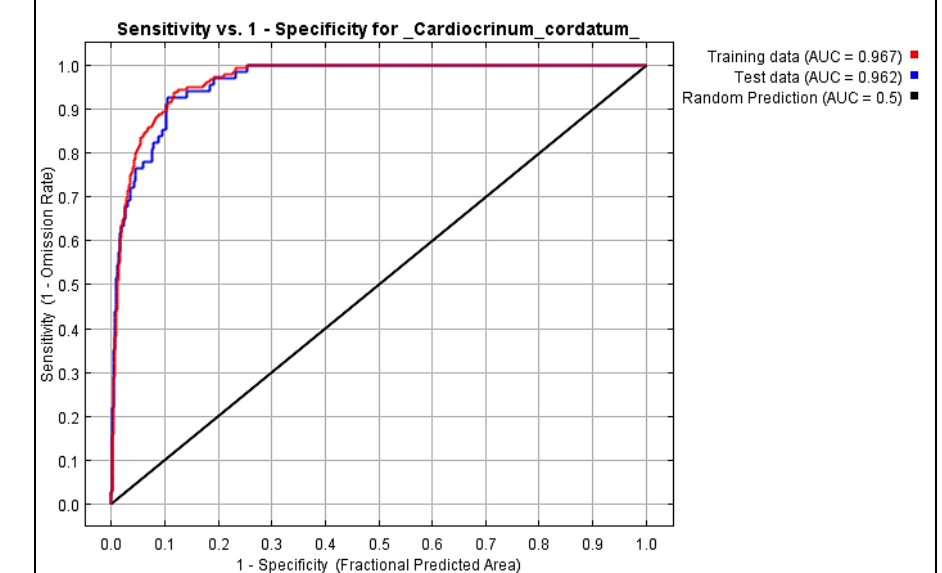
Figure 4. Receiver operator characteristic (ROC) curve for habitat suitability map of C. cordatum produced by MaxEnt model.